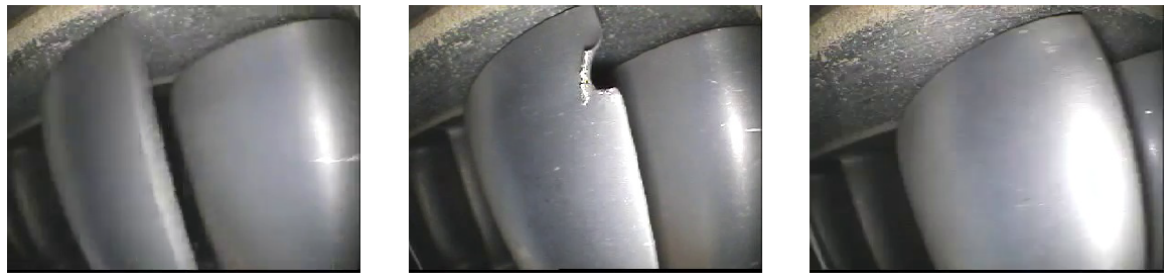
Figure 2. Sample images obtained through the image acquisition